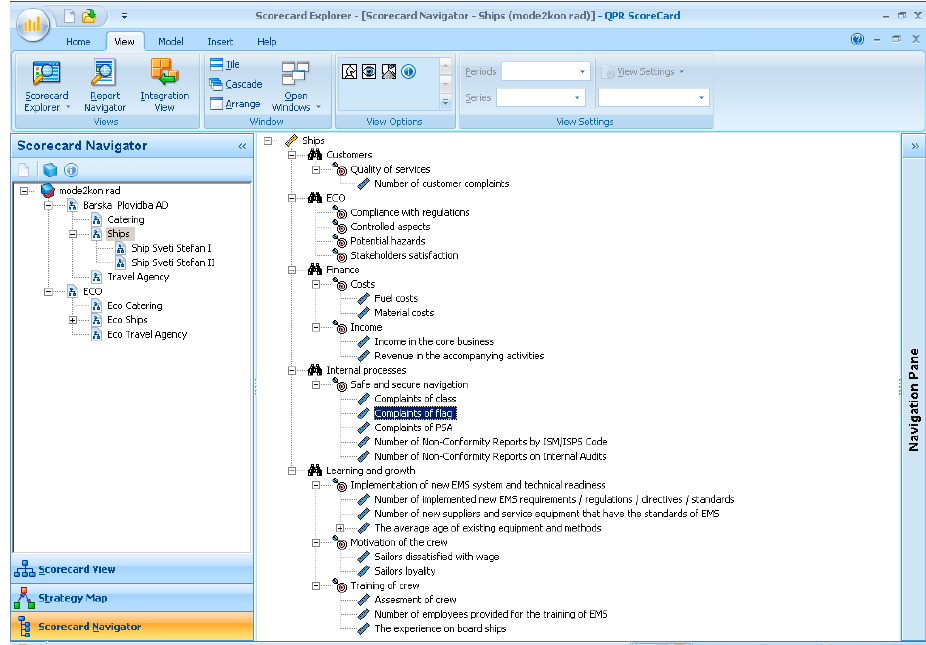
Figure 5. Model 2: Connection between the conventional BSC and ECO BSC by a new perspective called ECO.